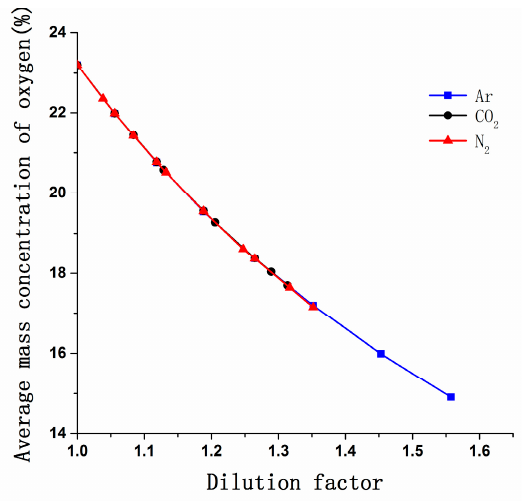
Figure 7. Variation in the O 2 concentration in the cylinder vs. the DF of CO 2 , N 2 , and Ar.